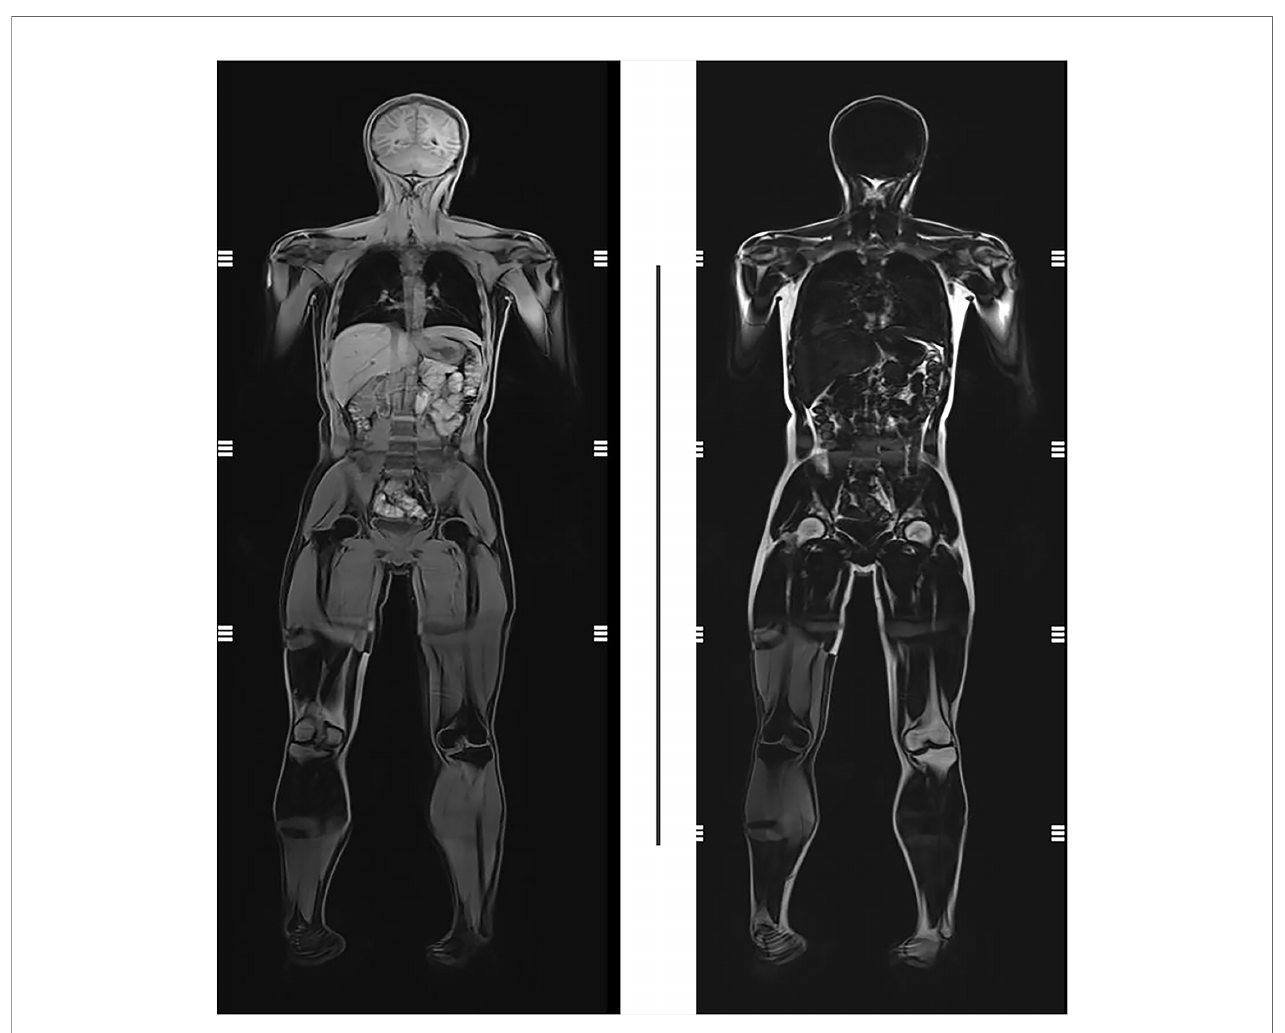
FIGURE 2 | Quantitative MRI of fat of the proband. No reduction or abnormal distribution of fat was presented.